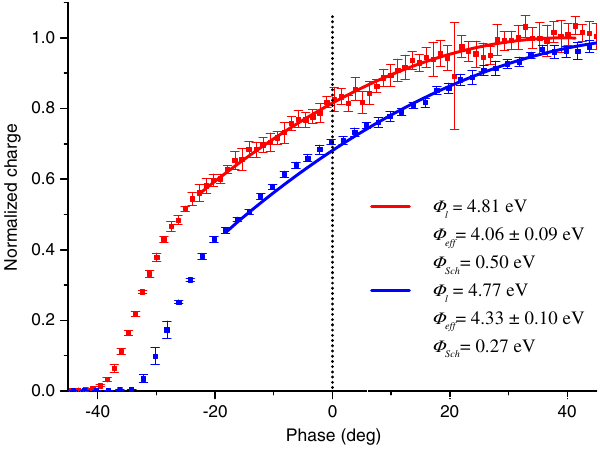
FIG. 5. Charge as a function of injection phase at 257.5 nm laser wavelength (red points) to determine effective work function and at 260 nm a month earlier (blue points). Best fit (solid red line) results in a work function of 4.56 eV and a field enhancement factor of 4.18, corresponding to 0.50 eV Schottky effect, while for the second case (blue line) a work function of 4.60 eV and a field enhancement factor of 1, corresponding to 0.27 eV Schottky effect. Zero degree is the operational phase for the intrinsic emittance measurements.